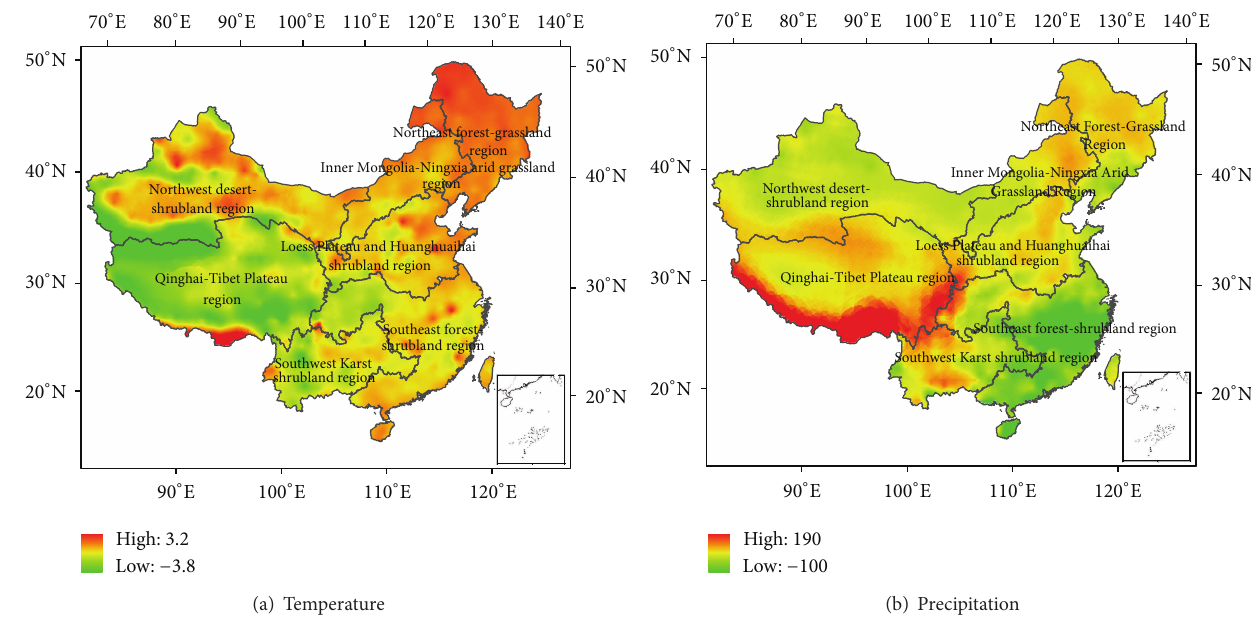
Figure 5: The change of the temperature and precipitation using CMIP5 GCM from 2010 to